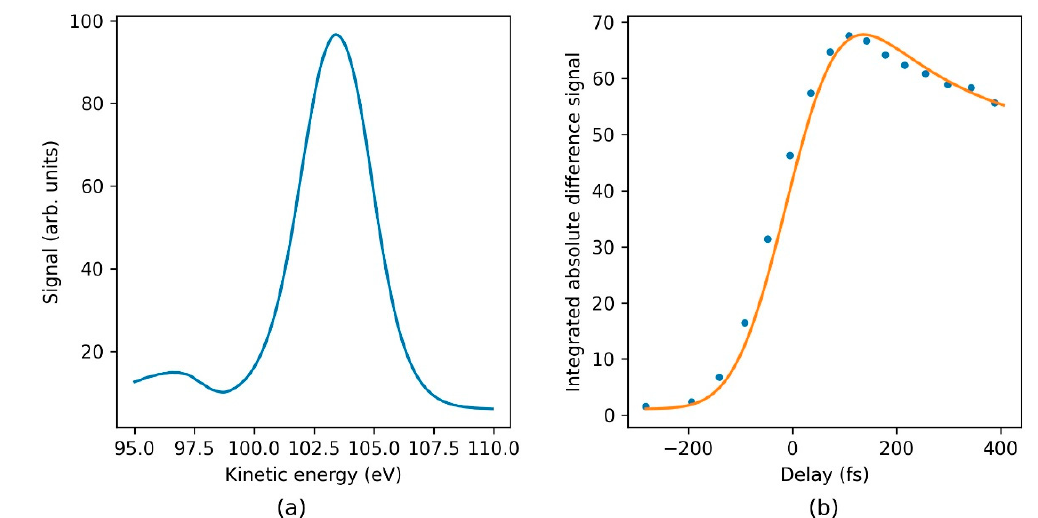
Figure 5. ( a ) Experimental photoelectron spectrum showing the sulfur-2p photoline of 2-thiouracil taken with a photon energy of ~270 eV. ( b ) Increase of the absolute value in the difference signal |(UV on − UV off )| as a function of pump-probe delay (blue dots) and fit by the model explained in the text (orange line).